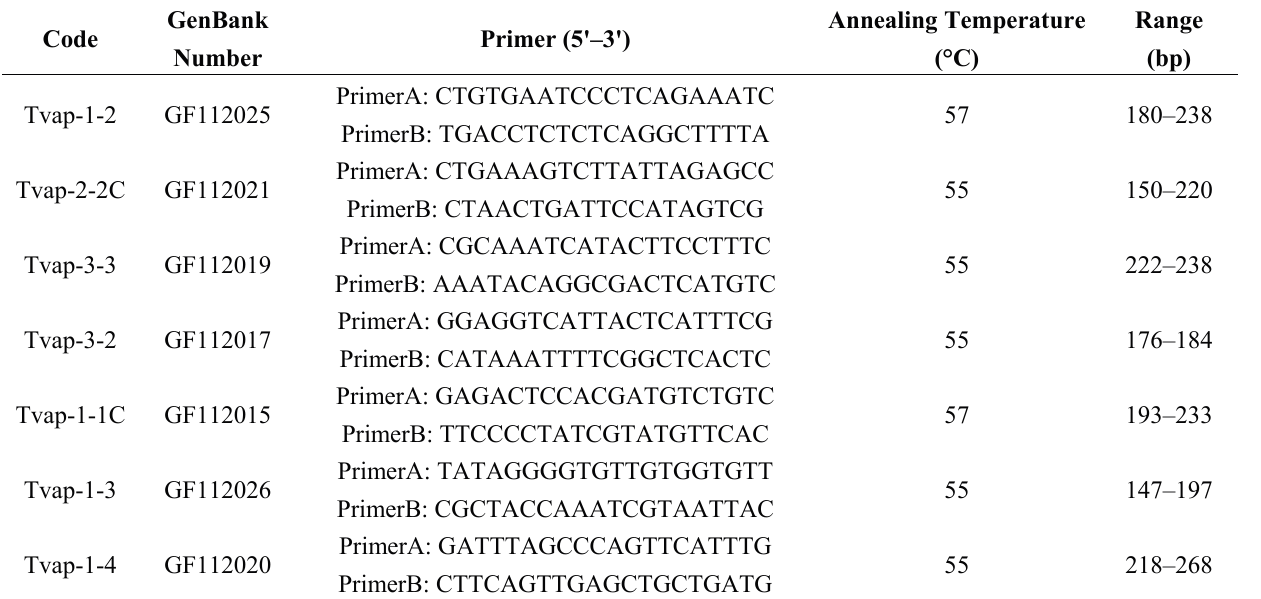
Table 4. The seven pairs of microsatellite primers used in this study (as previously described in Ovcarenko et al.